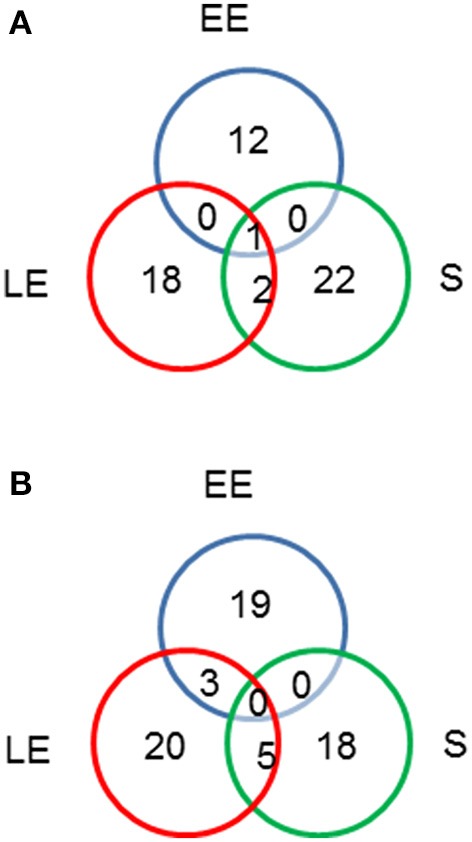
Distribution of proteins showing abundance level changes (p < 0.05) between wild-type and ΔmsrAB mutant strains. Venn diagrams showing the number of regulated intracellular proteins (A) and exoproteins (B) in the ΔmsrAB mutant in the early exponential (EE), late exponential (LE) and stationary (S) growth phases.